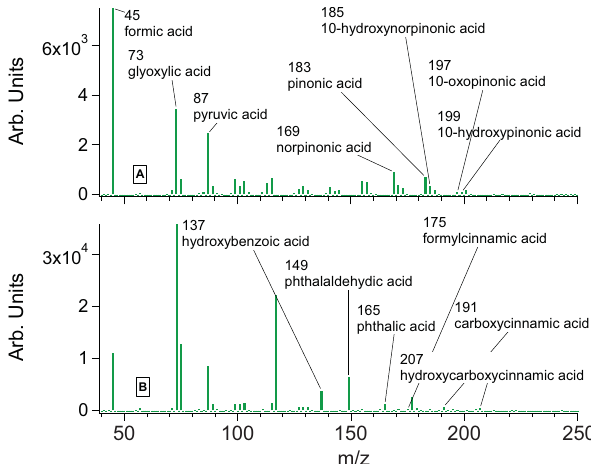
Figure 2. Acetate-CIMS unit mass resolution spectra of α - pinene ozonolysis ( a , Expt 1), and naphthalene photooxidation ( b , Expt 12). Even-massed ions, reagent ions, and dominant back- ground ions are removed, and blank spectra are subtracted. Se- lect ions identified in previous studies are labeled (Yu et al., 1999; Kautzman et al.,